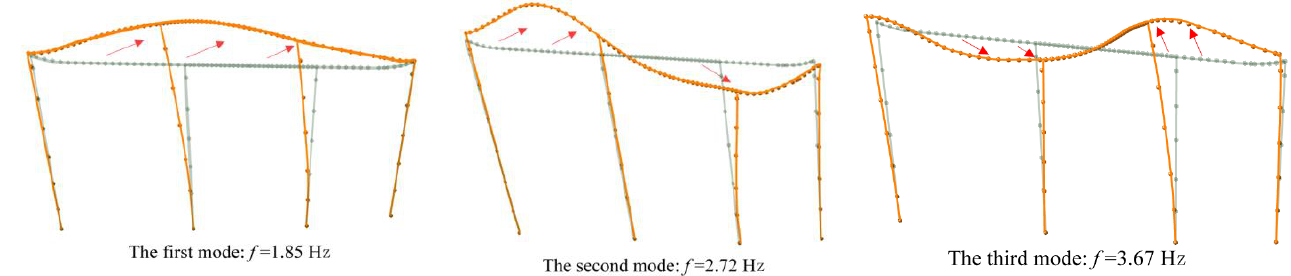
Figure 4. Time history and frequency domain signal of acceleration by the residual vibration method.